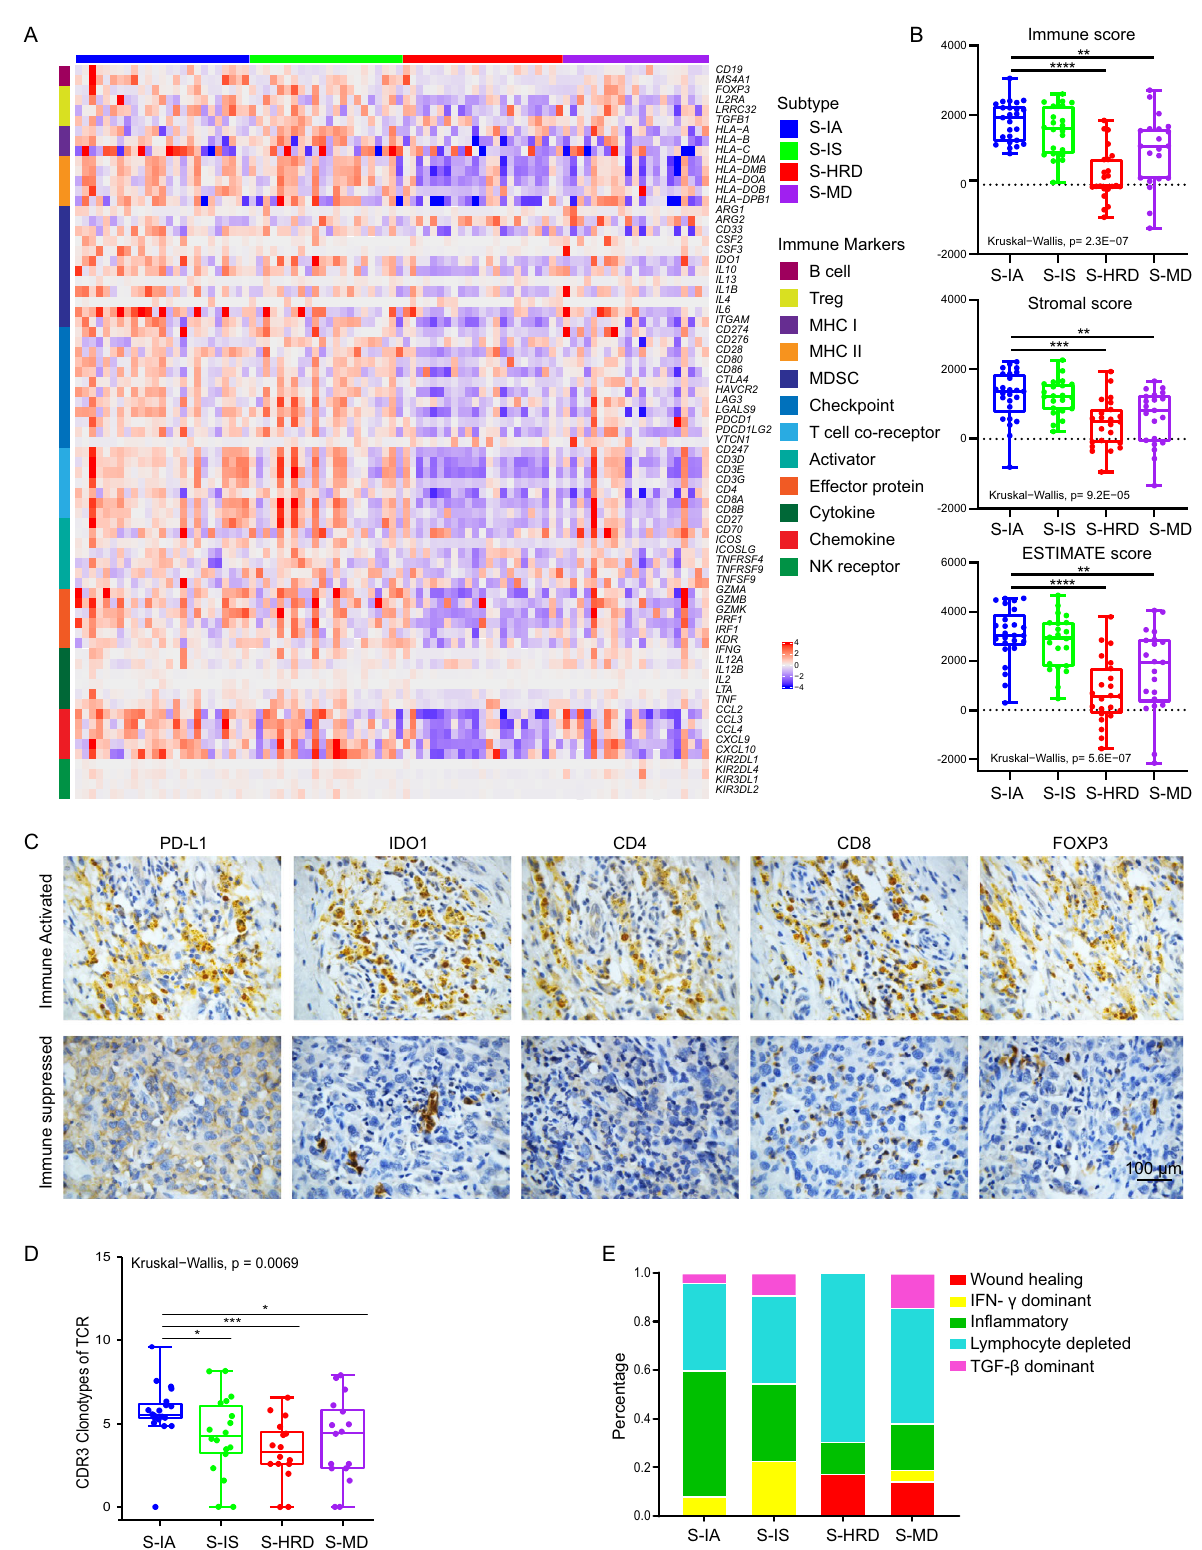
Fig.6|ImmunelandscapeofOS.A Heatmapof72curatedimmunemarkerswithin OSpatients.Theintegrativesubtypeinformationofeachpatientisannotatedatthe top. B The immune score, stromal in fi ltration score and ESTIMATE score among each integrative subtype. The statistical analysis was made by Kruskal – Wallis